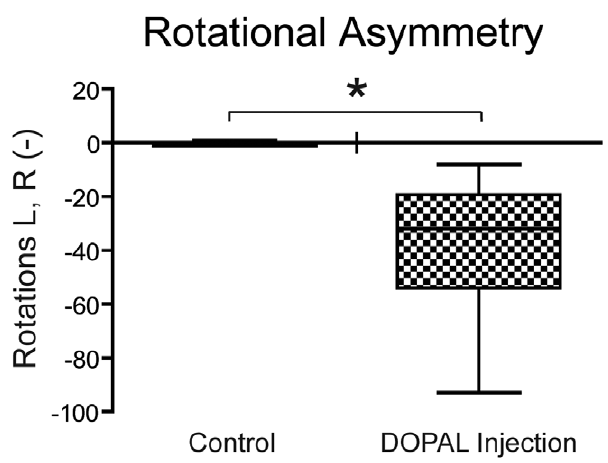
Figure 1. Box plot illustrating the behavioral changes in rats after unilateral injections of DOPAL into their substantia nigra. Rats showed rotational asymmetry, turning significantly towards the side of DOPAL injections. *p ,